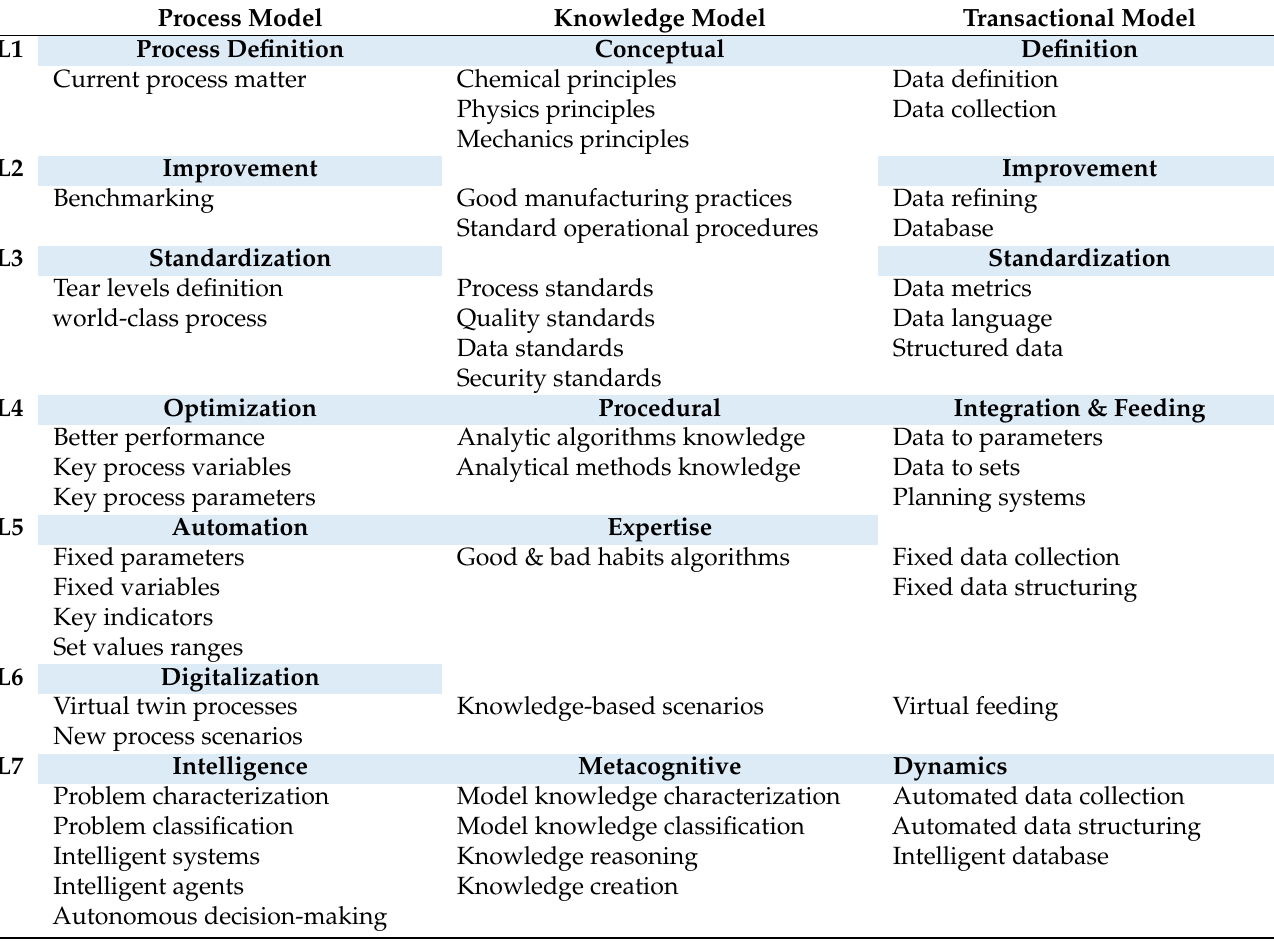
Table 1. Overall Intelligence Management Architecture for technology integration through process activities.